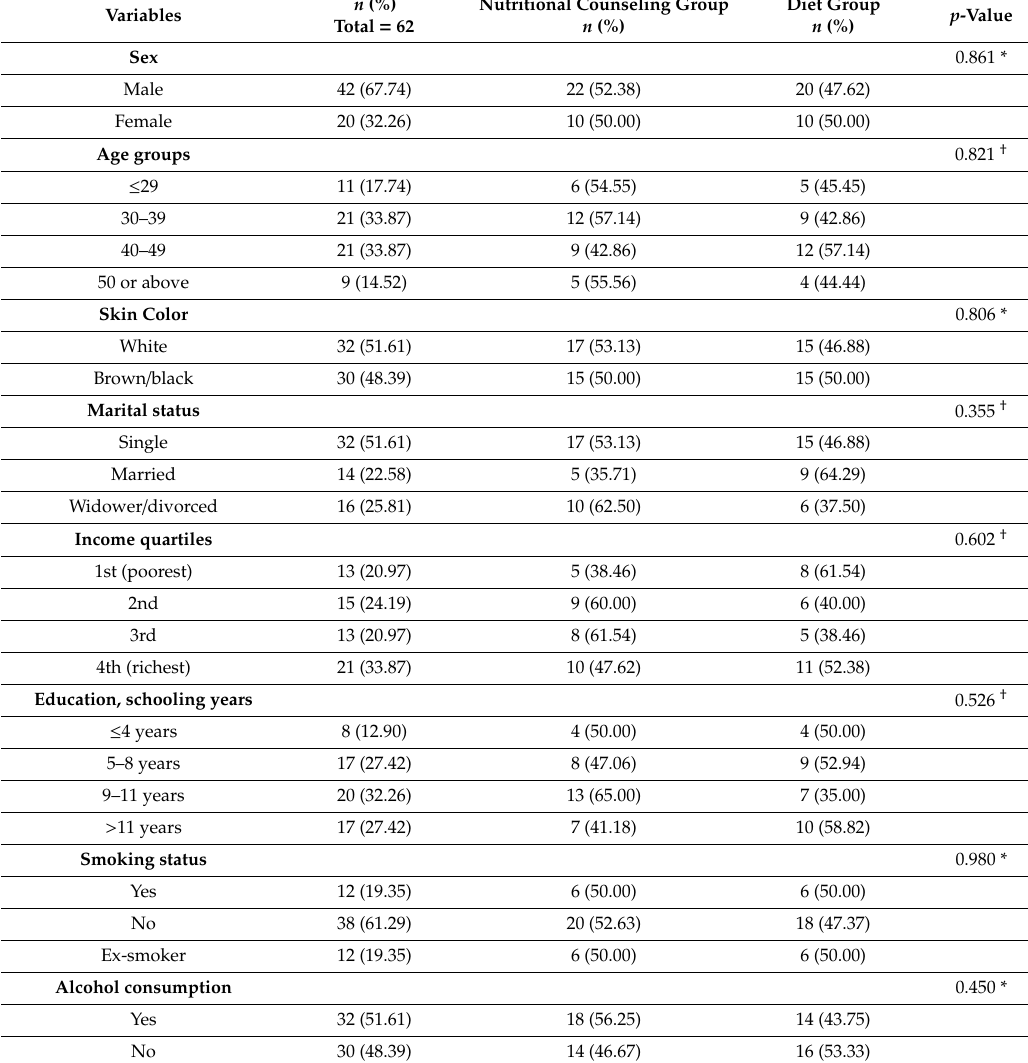
Table 1. Sociodemographic, clinical, and cardiometabolic data at baseline for people living with HIV / AIDS (PLWHA) according to their allocated